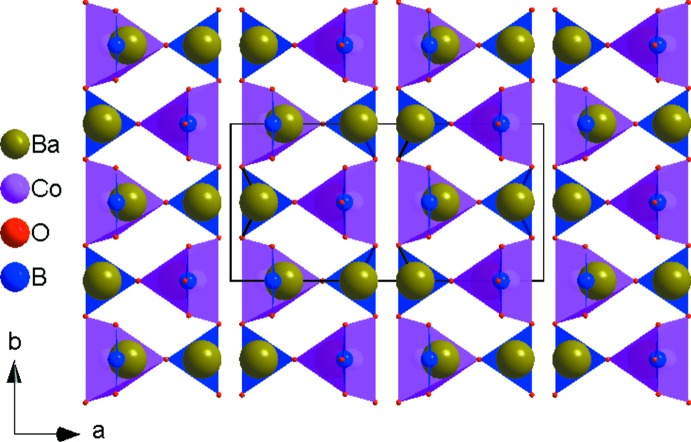
Projection of the crystal structure of Ba2Co(BO3)2 along [001].